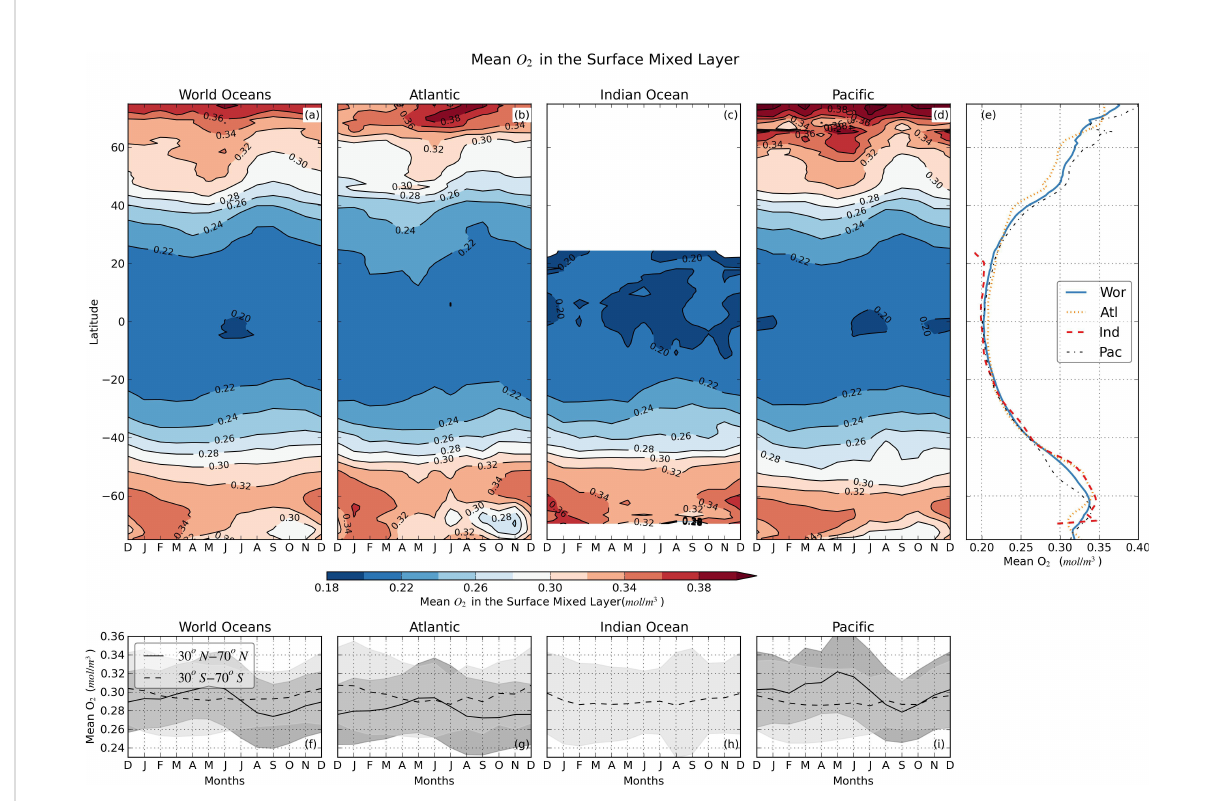
FIGURE 3 Climatology of mean O 2 concentration in the surface ML ( mol/m 3 ). Zonally averaged monthly mean oxygen concentration in the surface mixed layer for the (A) World, (B) Atlantic, (C) Indian, and (D) Paci fi c Ocean. Same colorbar used for panels (A – D) as shown below them. The contour interval is 0.02 mol/m 3 . (E) Annual zonally averaged oxygen for the world ocean and the three major basins. Monthly time series estimate of the mean oxygen between 30° and 70° for both northern Hemisphere (solid black) and Southern Hemisphere (dashed black) for the (F) World, (G) Atlantic, (H) Indian and (I) Paci fi c Ocean, respectively. The shadow areas in (F – I) represent the data